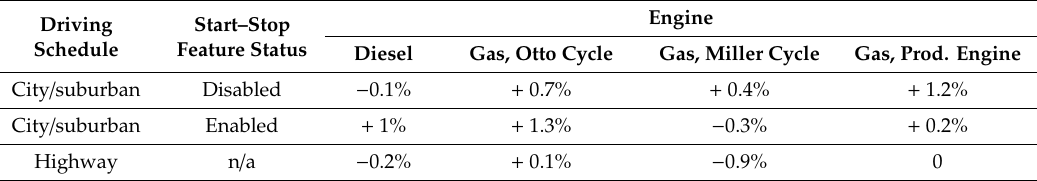
Table 10. Variations of the average fuel-saving e ff ect due to the decreased vehicle